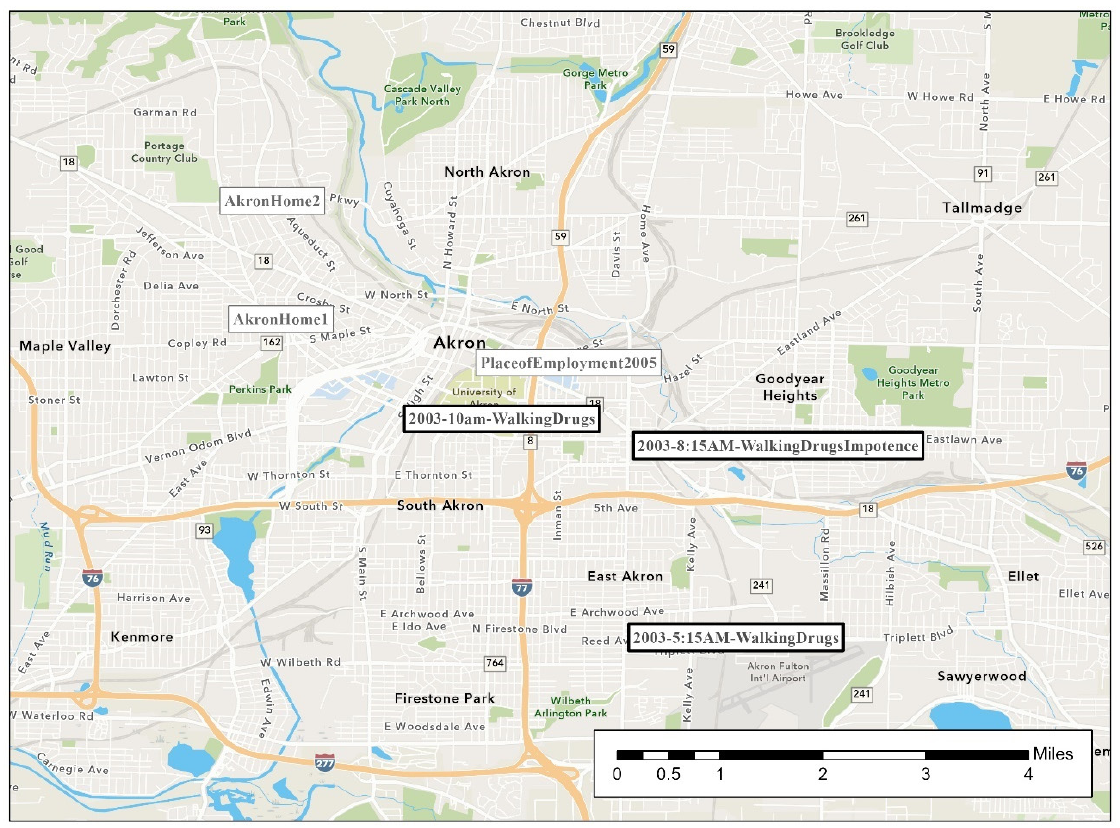
Figure 5. Akron’s Sexual Assault Locations, Offender Place of Employment, and Offender Known